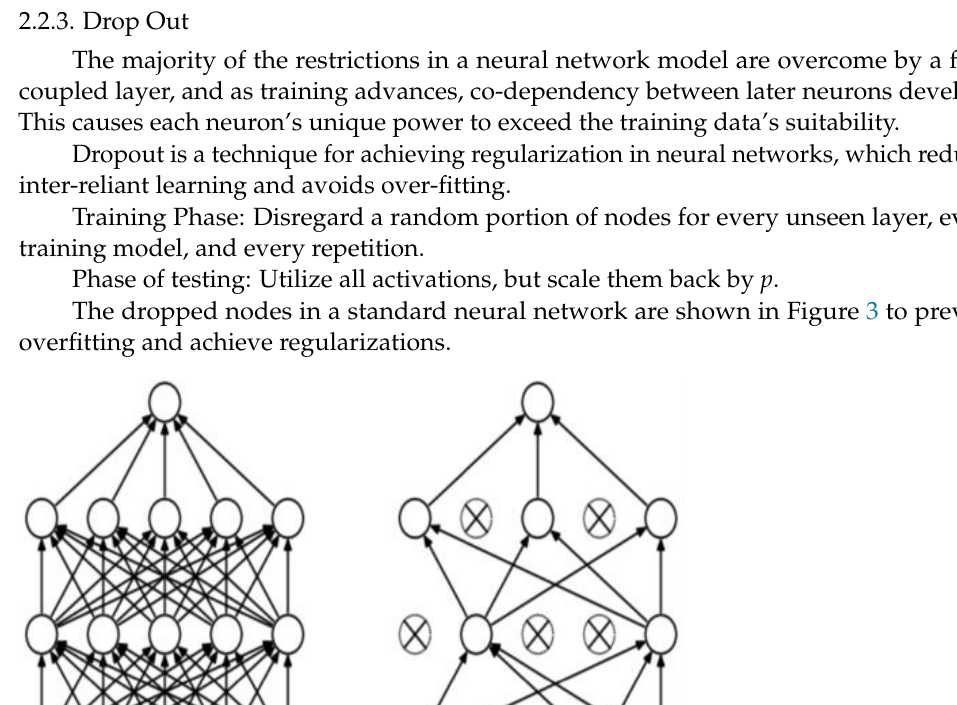
Figure 2. Softmax Activation function overview.